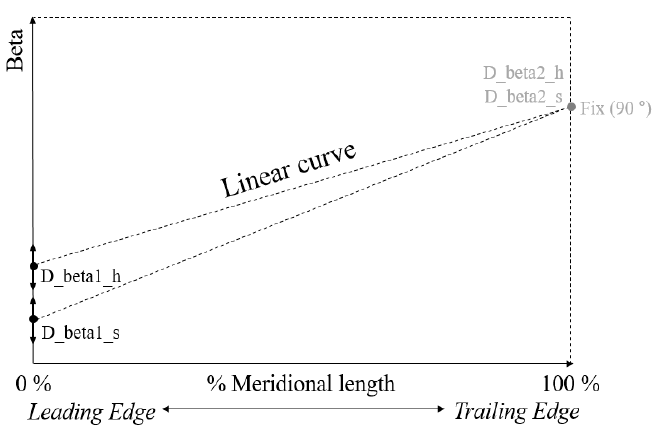
Figure 5. Definition of design variables of the diffuser.